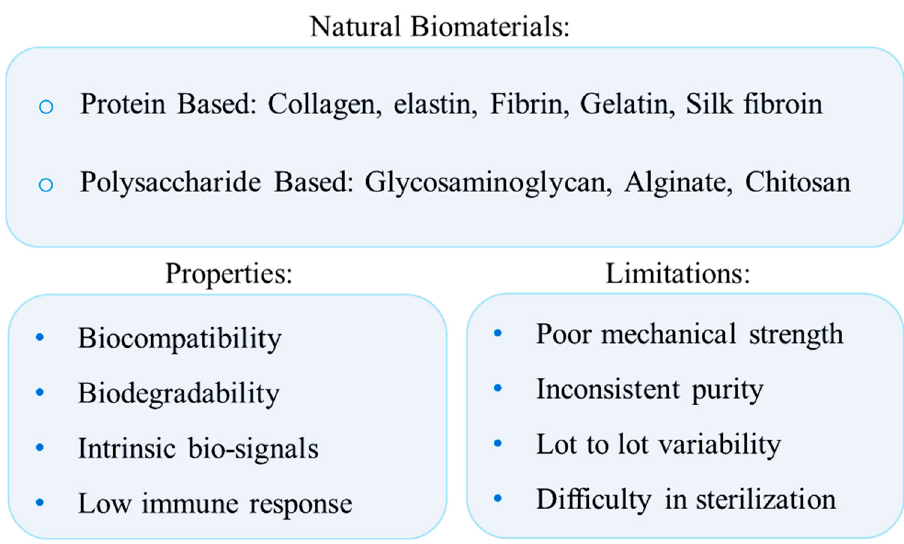
Figure 1. Natural biomaterials. Please, see the main text above for detailed